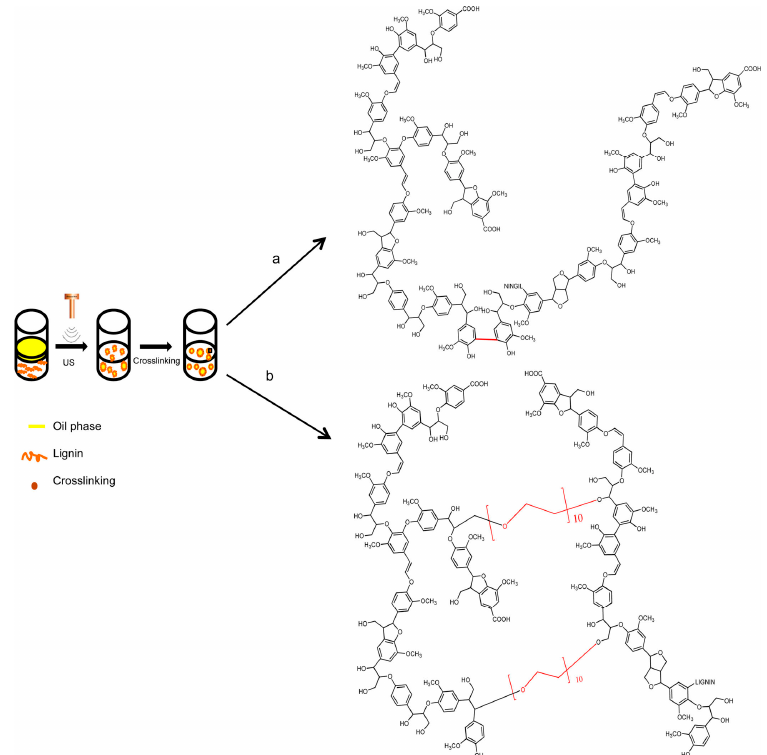
Figure 7. Schematic representation of the production method and of crosslinking routes. Route ( a ) No additional crosslinking agent; route ( b ) cross-inking by addition of PEGDEG. Reprinted with permission from Tortora et al. [20]. Copyright 2014 American Chemical Society.